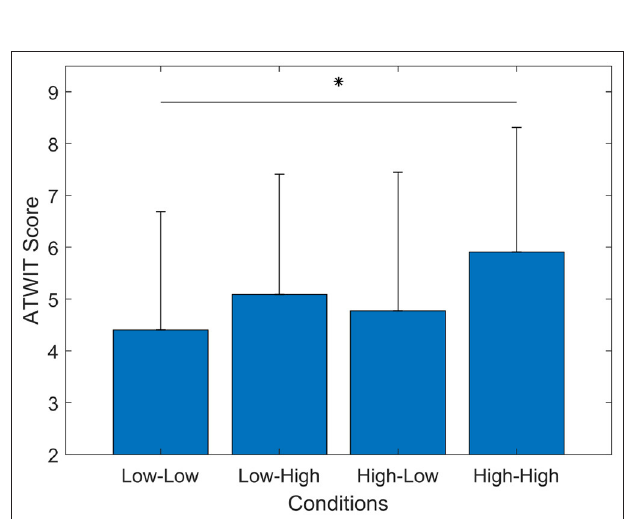
FIGURE 3 | Analysis workflow used in the present study.